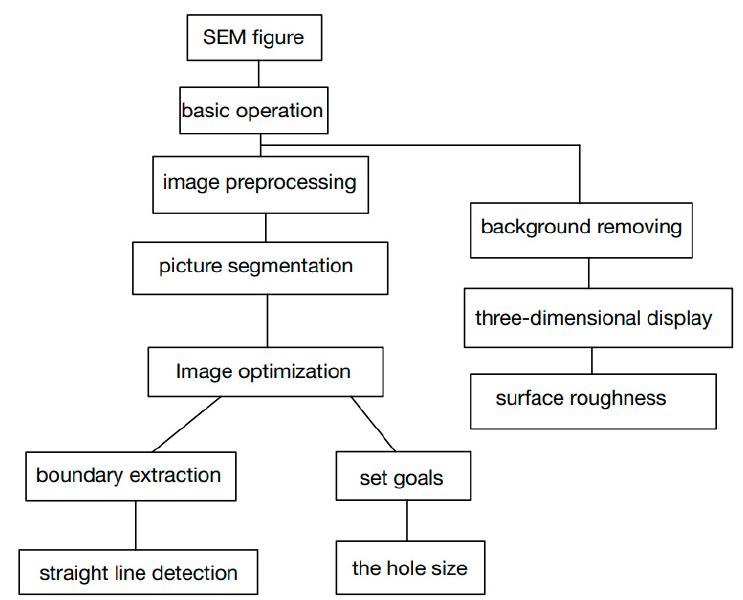
Figure 2. Flow diagram of image processing algorithm.